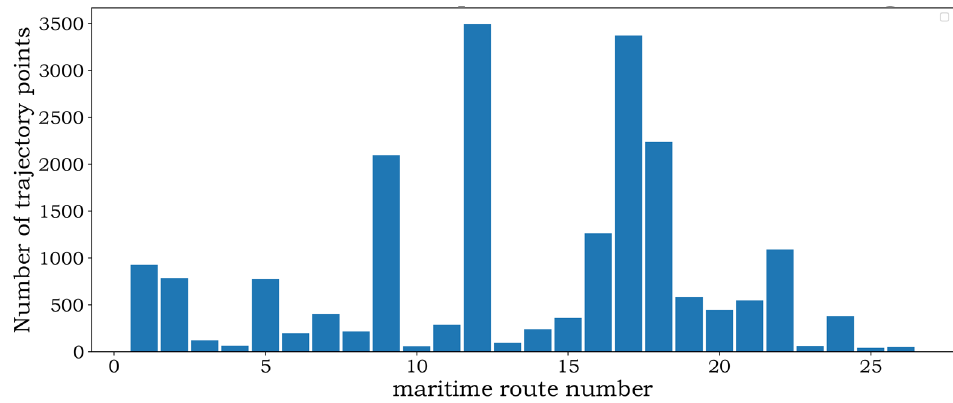
Figure 14. Statistics for the number of trajectory points in the maritime route segments.